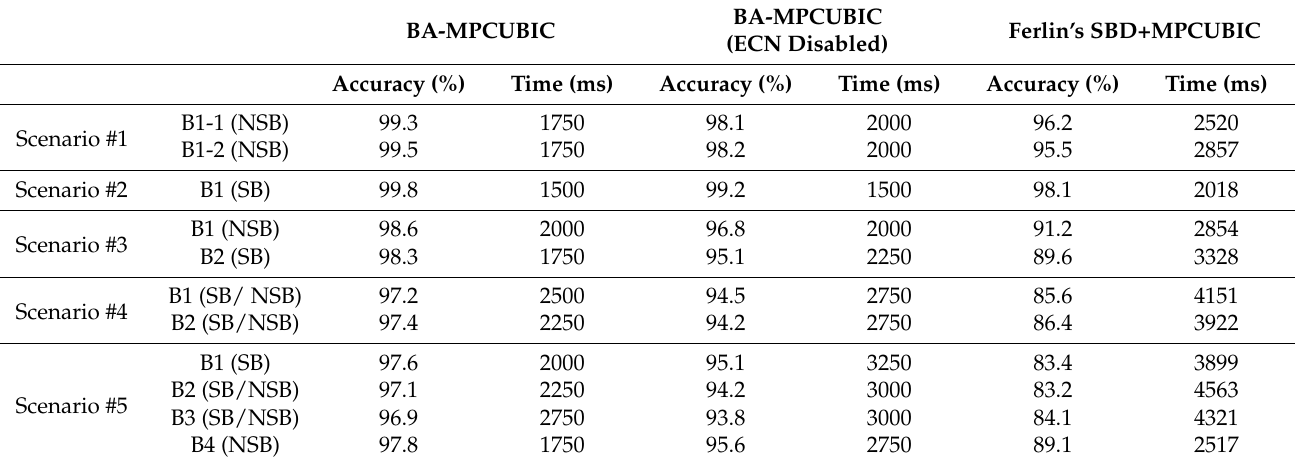
Table 2. Performance comparison in terms of detection accuracy and detection time in Scenarios #1–5.